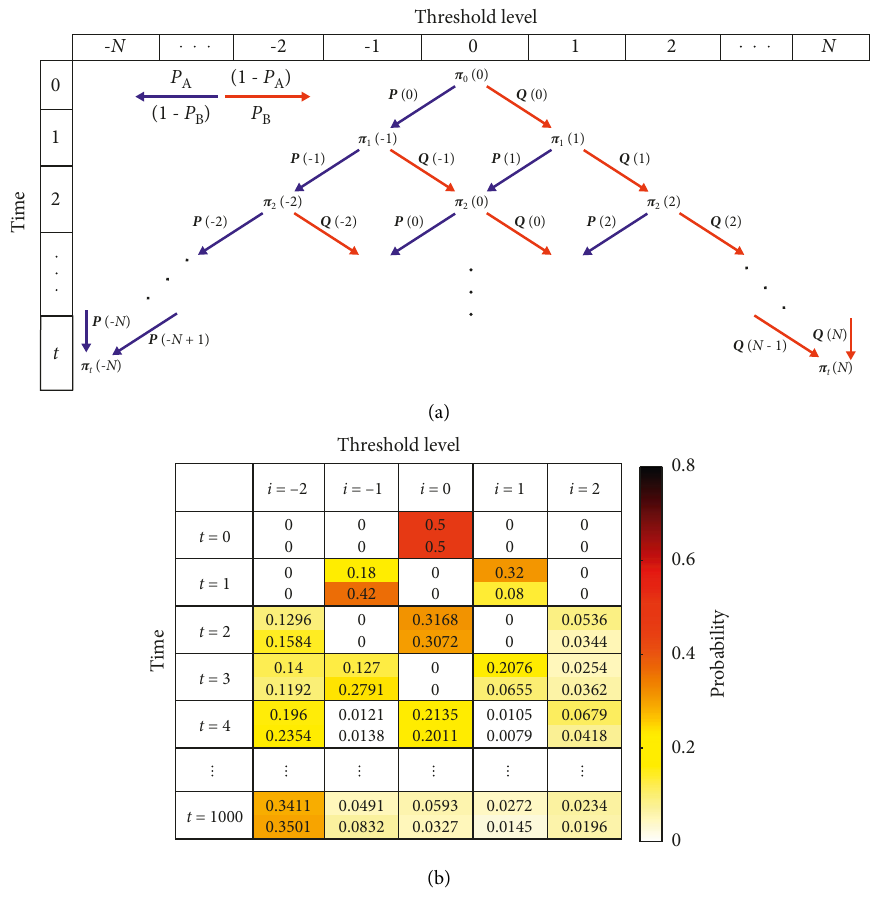
Figure 5: (a) Chains of the probability vector π ( i ) given by equations (11), (14), and (16). (b) An example of the evolution of probability t ( 0 ) � ( 0 . 5 , 0 . 5 ) , the autocorrelation coefficient λ is − 0.8, the threshold number is specified by vector π t ( i ) when the initial condition is π 0 N � 2, and the reward environment is ( P A , P B ) � (0.9, 0.7).